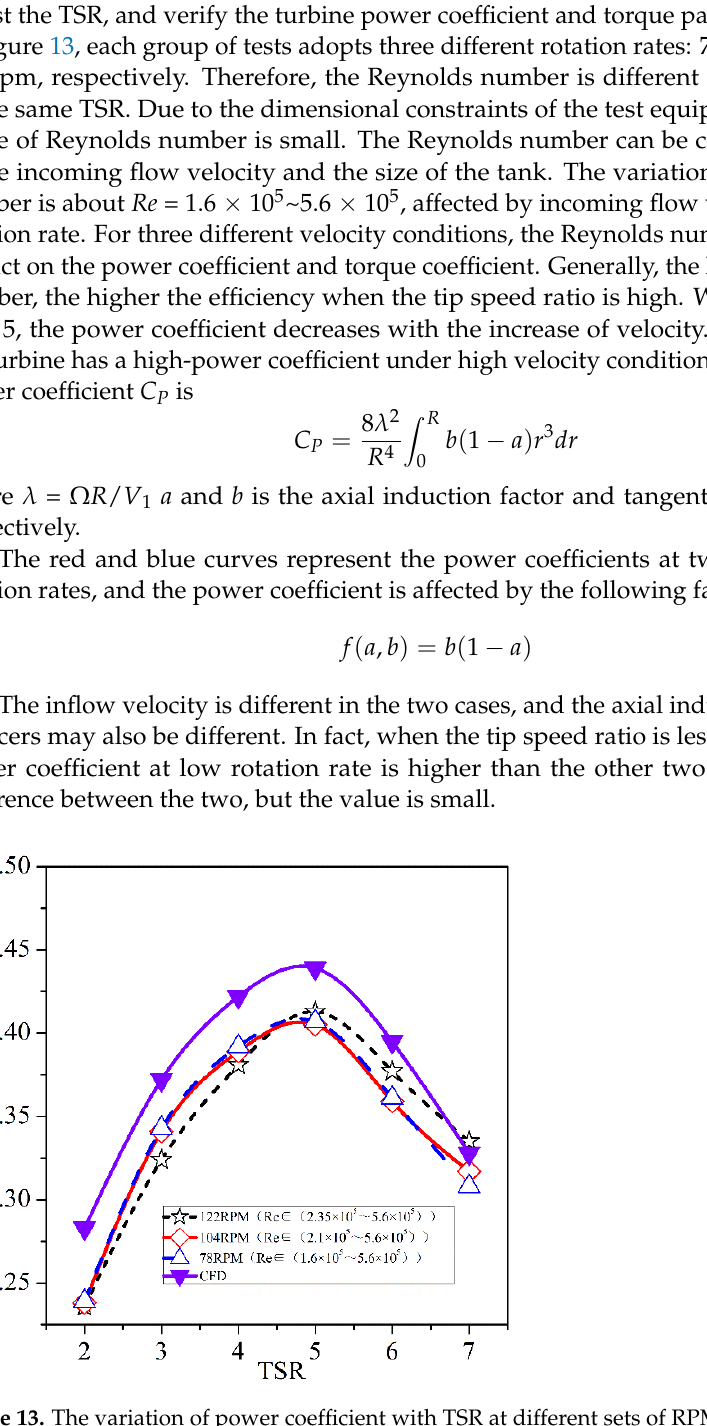
Figure 13. The variation of power coefficient with TSR at different sets of RPMs.